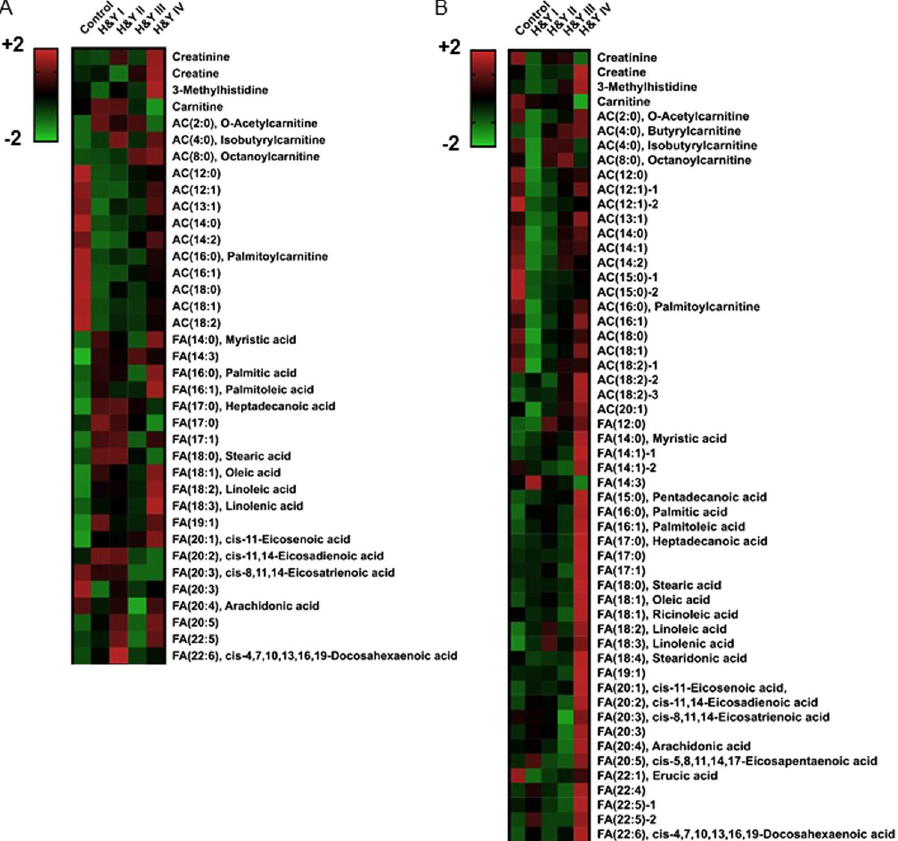
Figure 2. Decreased levels of long-chain acylcarnitines were detected maximally in the early stage (H&Y stage I) of Parkinson’s disease ( A , B ). Levels of muscular metabolites, long-chain acylcarnitines, and long-chain FAs of each Parkinson’s disease H&Y stage in each cohort are summarized in each heat map. Abbreviations: AC = acylcarnitine; H&Y = Hoehn and Yahr stage; FA = fatty